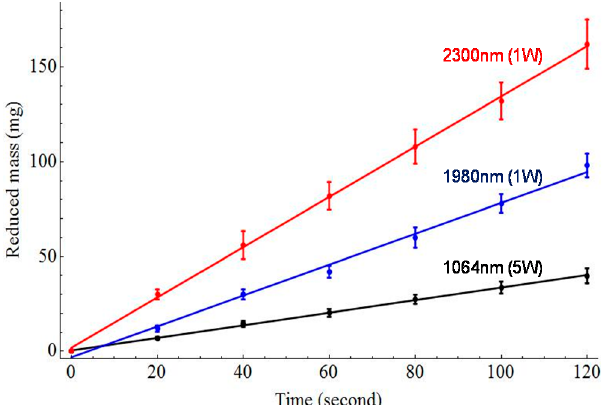
Figure 8. Measured reduced mass of tissue samples with different laser irradiation times for pump, signal, and idler wavelengths. The points represent the experimental values and the solid lines are linear regression fits (n > 10).